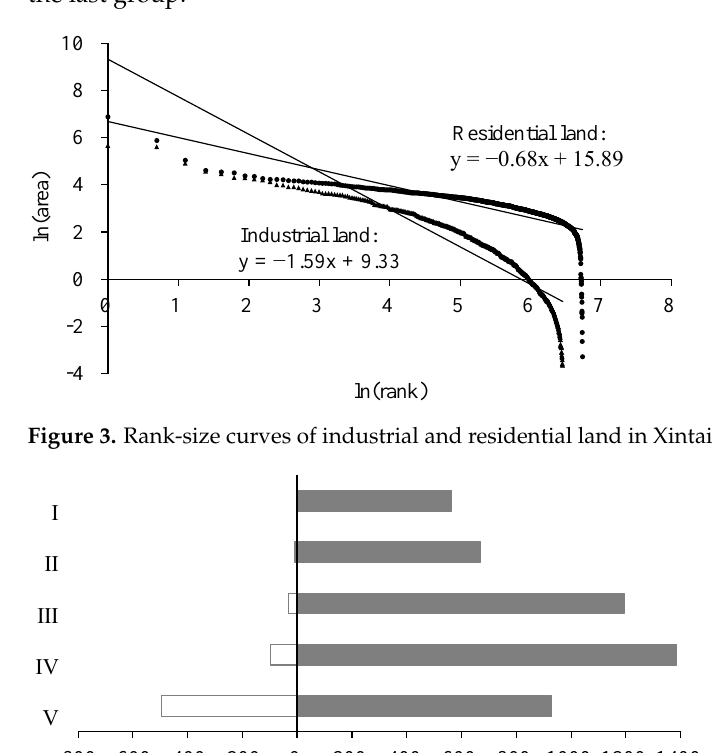
Figure 3. Rank-size curves of industrial and residential land in Xintai.